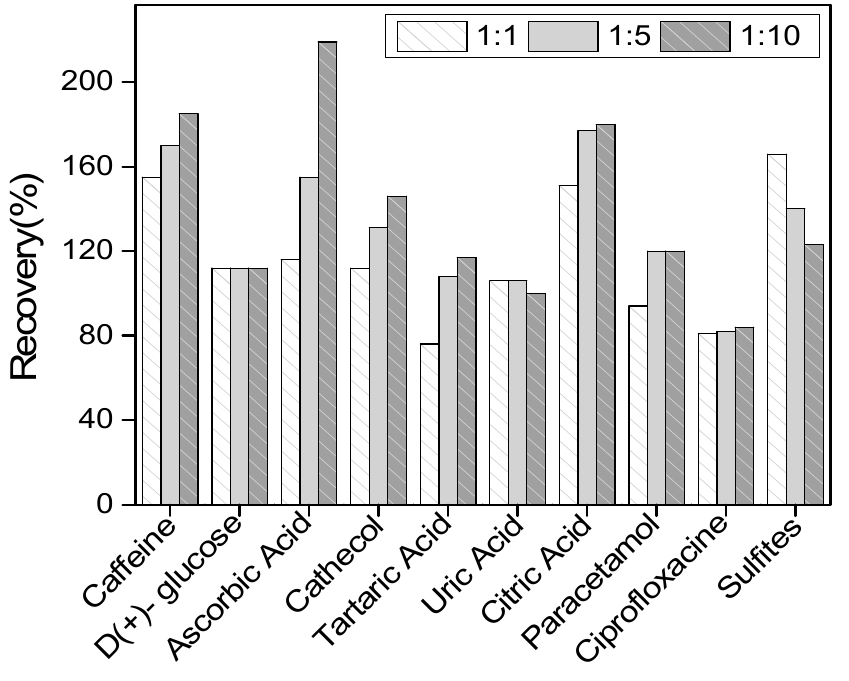
Figure 9. Influence of various potentially interfering compounds on the differential pulse voltammetry (DPV) response in the presence of quercetin (QCT) at 10 − 4 M .